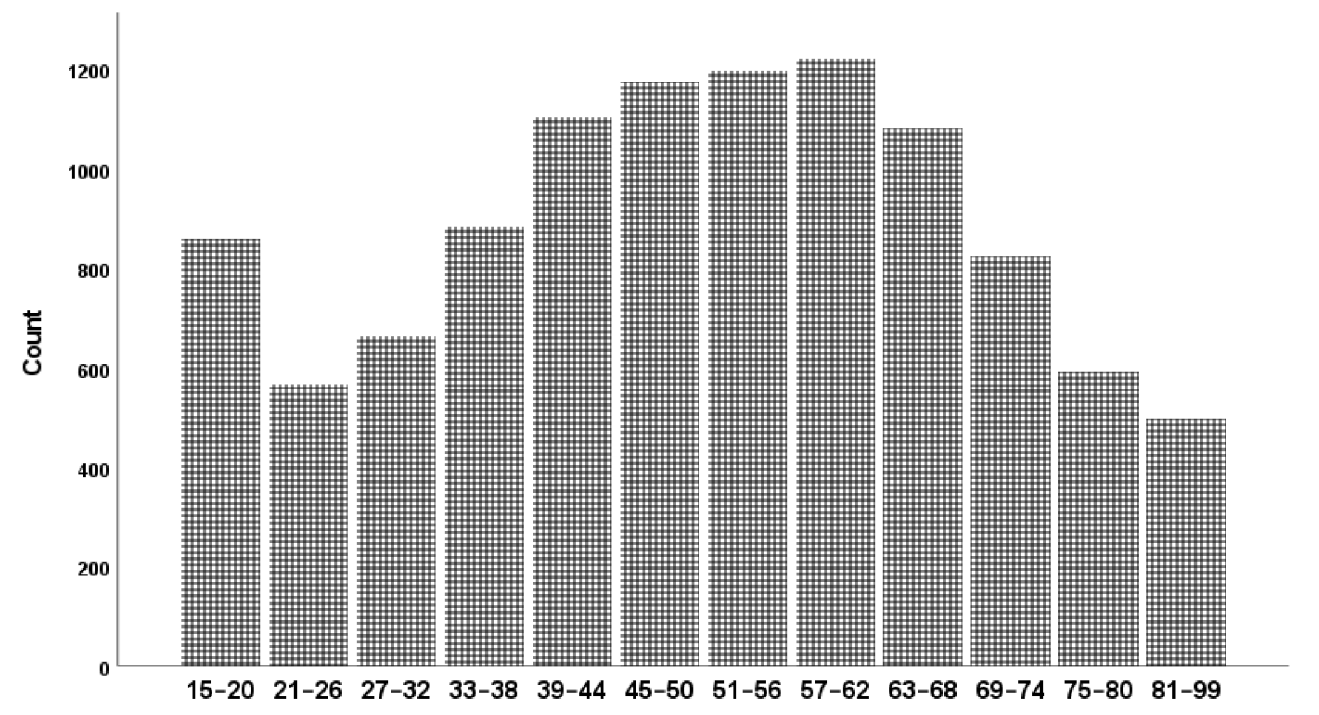
Figure 1. Age distribution ( N = 10,799).